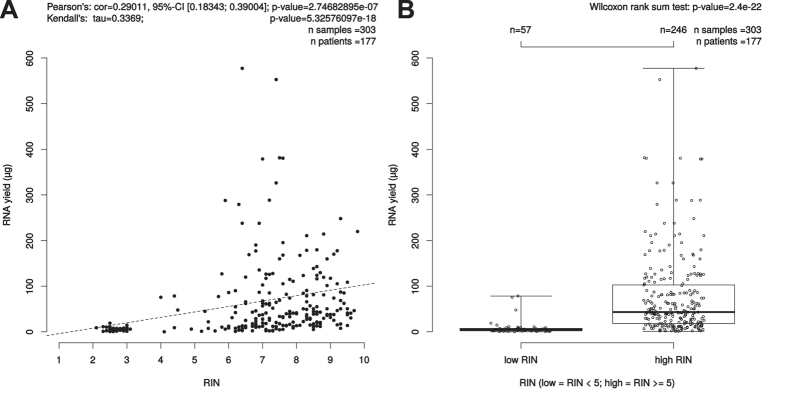
Correlation between isolated RNA yield (μg) and RIN.(A) Scatterplot: Pearson’s correlation coefficient (r) and due to skewedness of the data also Kendall’s rank correlation tau were depicted as measures. Kendall’s rank correlation yielded a tau of 0.3369027 and had a p-value of <5.32576097e-18. (B) Boxplot: The bimodal distribution of RIN values was the trigger to further investigate the Wilcoxon test results for the low/high RIN classes, which result here in a p-value of 2.4e–22.